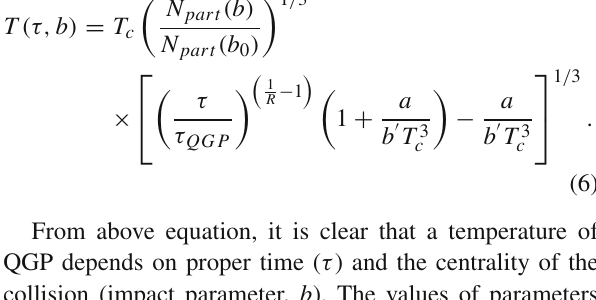
Table 1 The values of σ NN ϒ( and σ NN cross-sections at b ¯ b